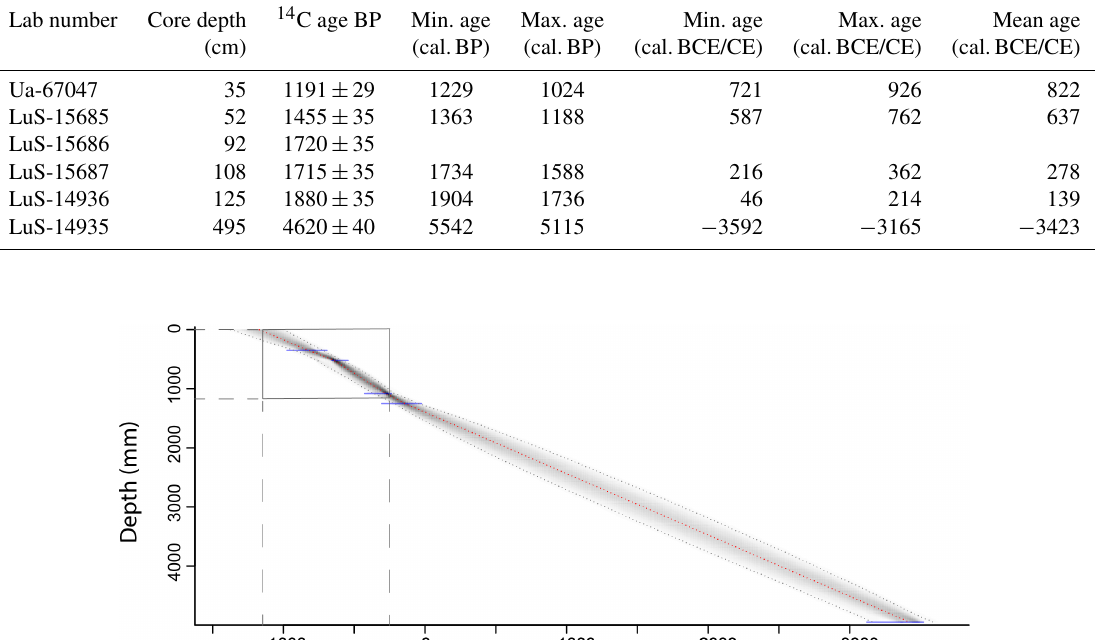
Table A2. Radiocarbon ages for Ulbergmyr peat sequence.